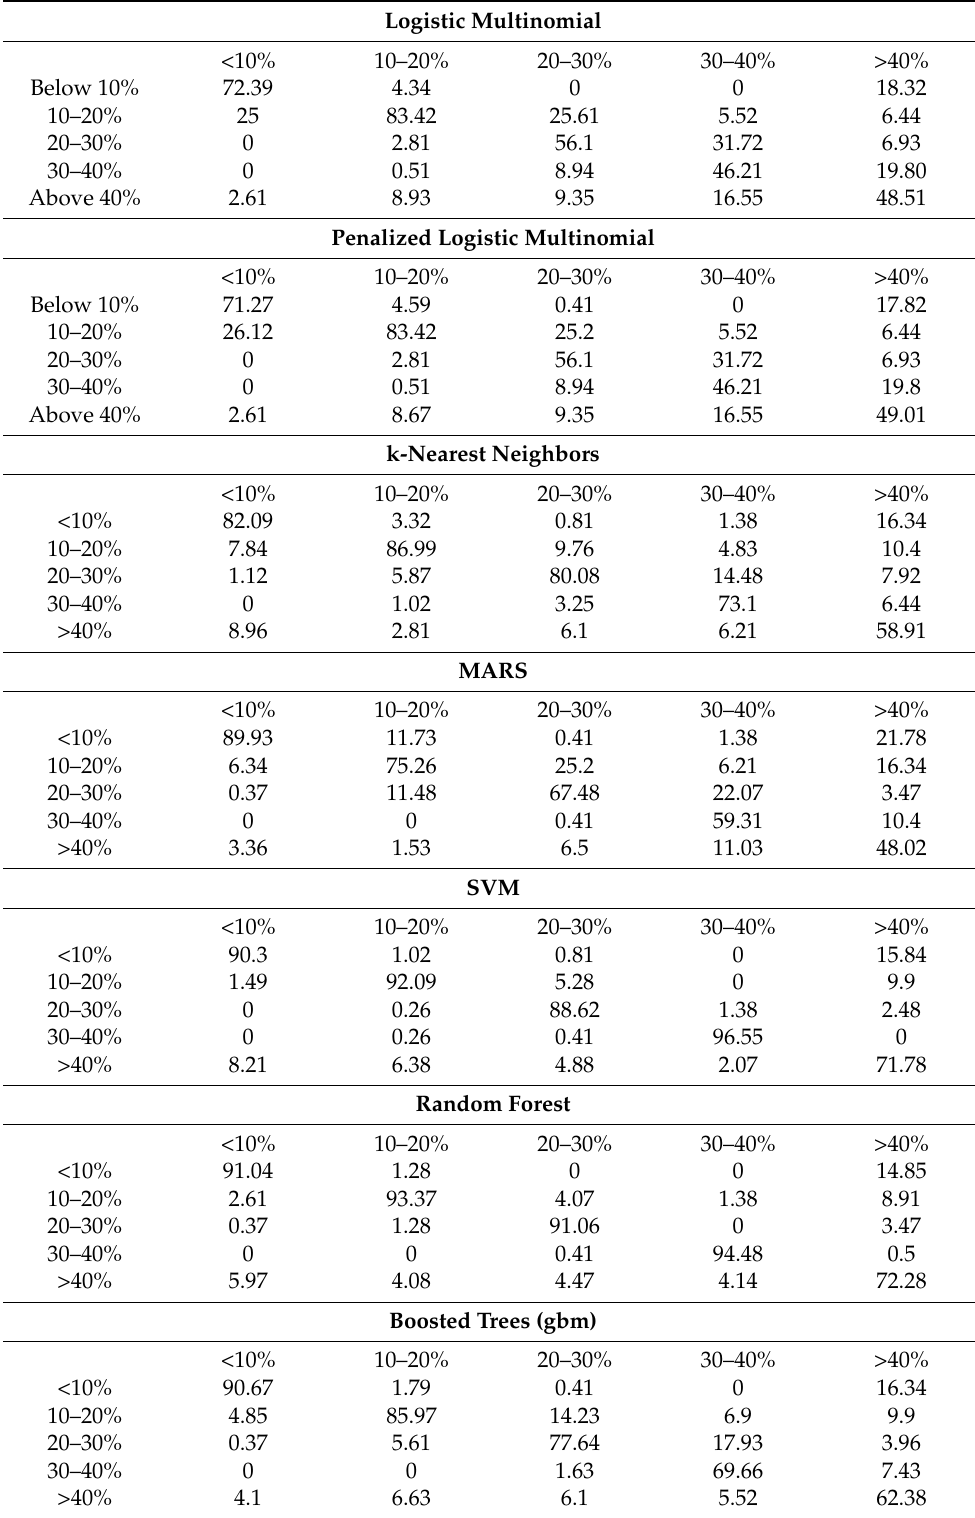
Table 3. Classification tables for each technique in the test